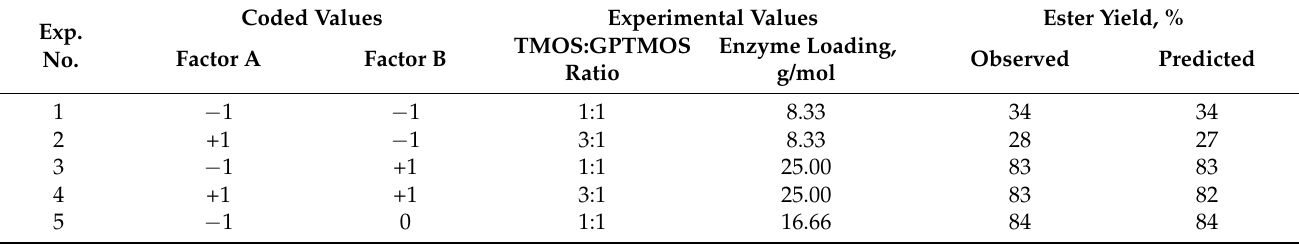
Table 1. Experimental setup with coded and experimental values of the immobilization parameters and system